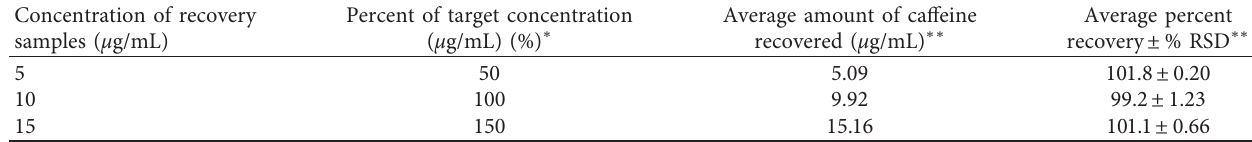
Table 3: Recovery analysis results of caffeine in commercial energy beverage